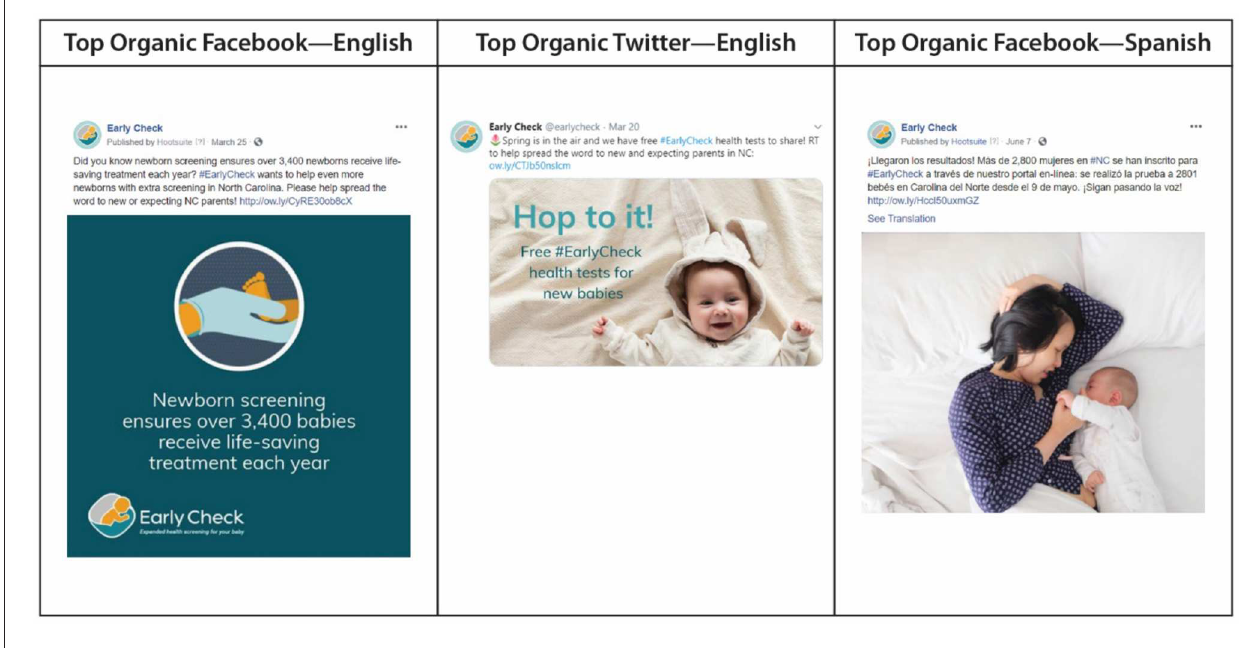
FIGURE 1 | Top-performing organic social media posts.